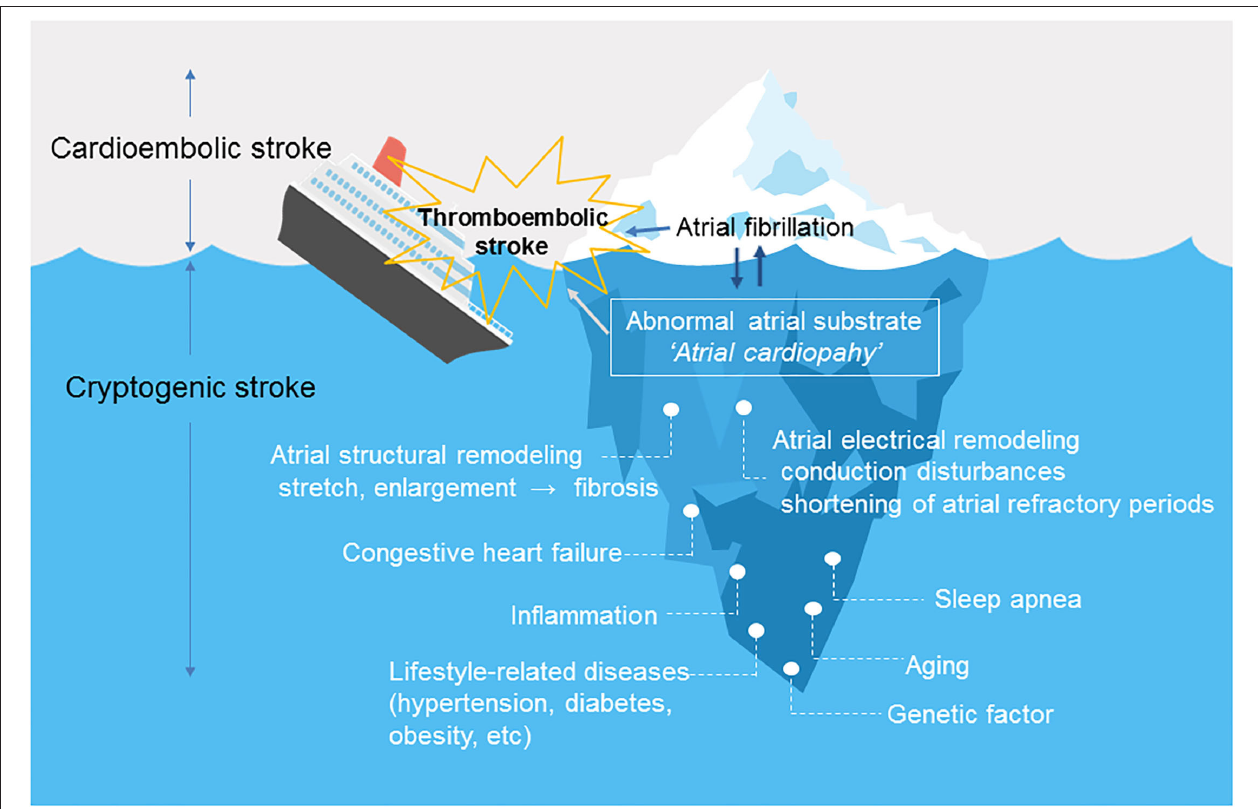
FIGURE 1 | Atrial cardiopathy as a cause of thromboembolic stroke. Atrial fibrillation is likely only a marker (tip of the iceberg) for underlying abnormal atrial substrate or “atrial cardiopathy”. Underlying atrial cardiopathy can cause stroke, even in patients without atrial fibrillation. Once atrial fibrillation develops, the dysrhythmia causes structural and electrical remodeling, which further increases the risk of